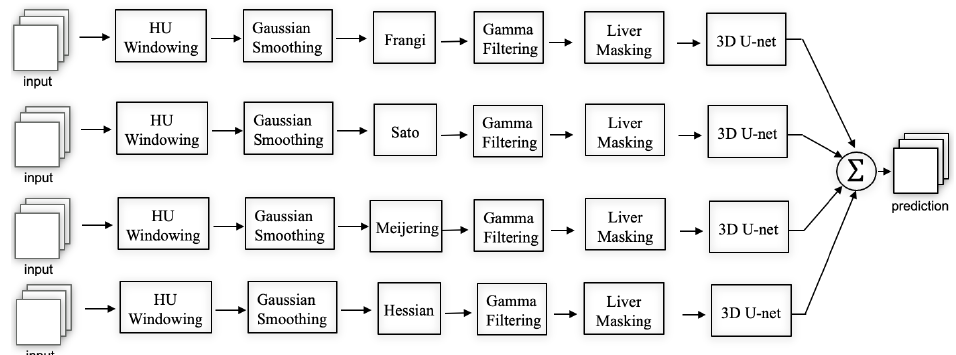
Figure 5. Workflow of the combined vesselness filter output (FilterAdded).